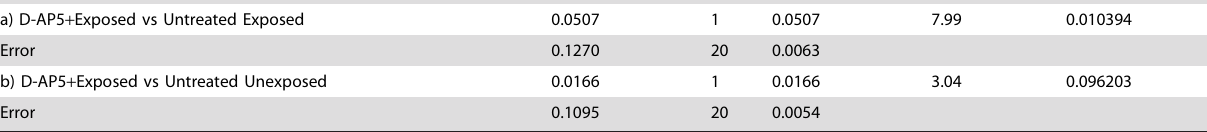
Figure 3. Psychophysical performance of Exposed (square data points) and Unexposed (round data points) groups. Prior to D-AP5 treatment, exposed animals were divided into two equal subgroups, one of which was randomly assigned to receive D-AP5 (open, square data points). A downward shift with respect to Unexposed controls was indicative of tinnitus. A . Pre-D-AP5 treatment there was no difference between the two exposed groups (error bars in all panels indicate the standard error of the mean) and both were significantly different than the Unexposed group